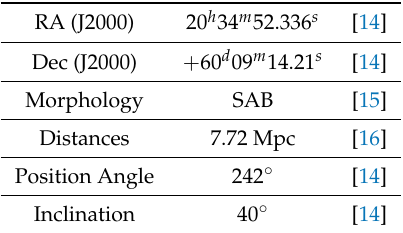
Table 1. Basic parameters of